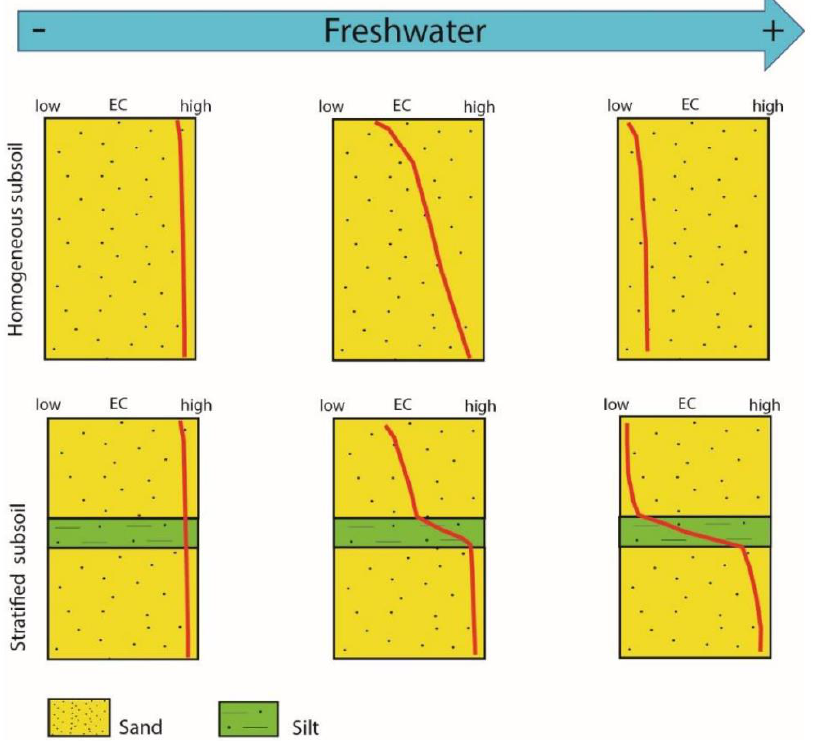
Figure 13. Conceptual model of the propagation of the mitigation signal in surficial aquifer charac- terized by homogeneous or stratified subsoil. The salinity of the groundwater is represented by the EC parameter.